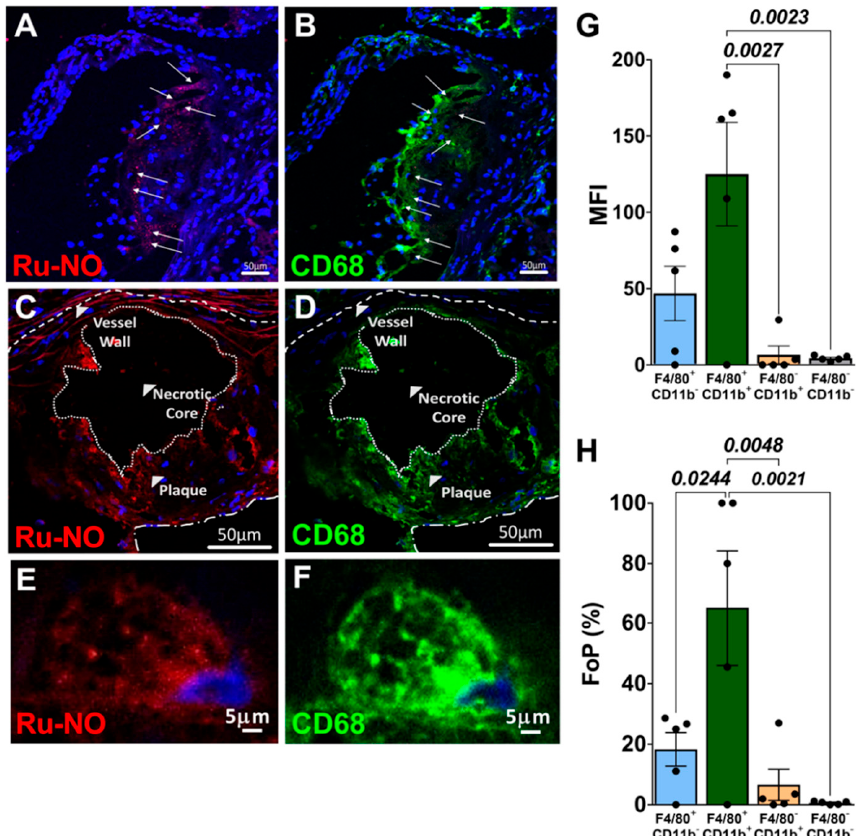
Figure 4. In vivo detection of Ru-NO in mouse atherosclerotic plaque . Detection of Ru-NO fluorescence in aortic sinus plaque following intravenous administration of Ru-NO (40 µ M) to Apoe − / − mice fed a high-cholesterol diet (HCD) for 12 weeks and imaged using confocal microscopy. ( A , C , E ): Distribution of the Ru-NO (red) in cellular areas of the plaques with nuclear stain DAPI (blue) with increasing magnification. ( B , D , F ): Comparison with plaque macrophage location (CD68 + , green). ( G ) Mean fluorescence intensity (MFI) and ( H ). frequency of parental (FoP) of aortic cell suspensions for the detection on Ru-NO fluorescence in non-myeloid cells (CD11b + F4/80 − ), myeloid cells (CD11b + F4/80 − ) and macrophages (CD11b + F4/80 + ) in HCD-fed mice post-Ru-NO infusion. Mean ± SEM, p values derived from a repeated measures one-way ANOVA with Tukey post-hoc test (n = 5 animals).